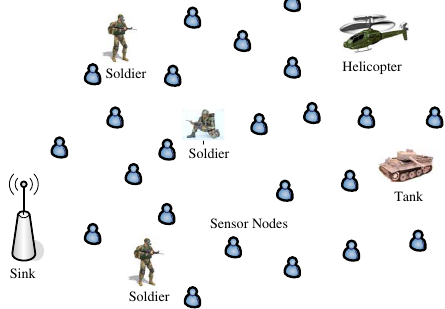
Figure 1. Collection of multiple classes of information in a